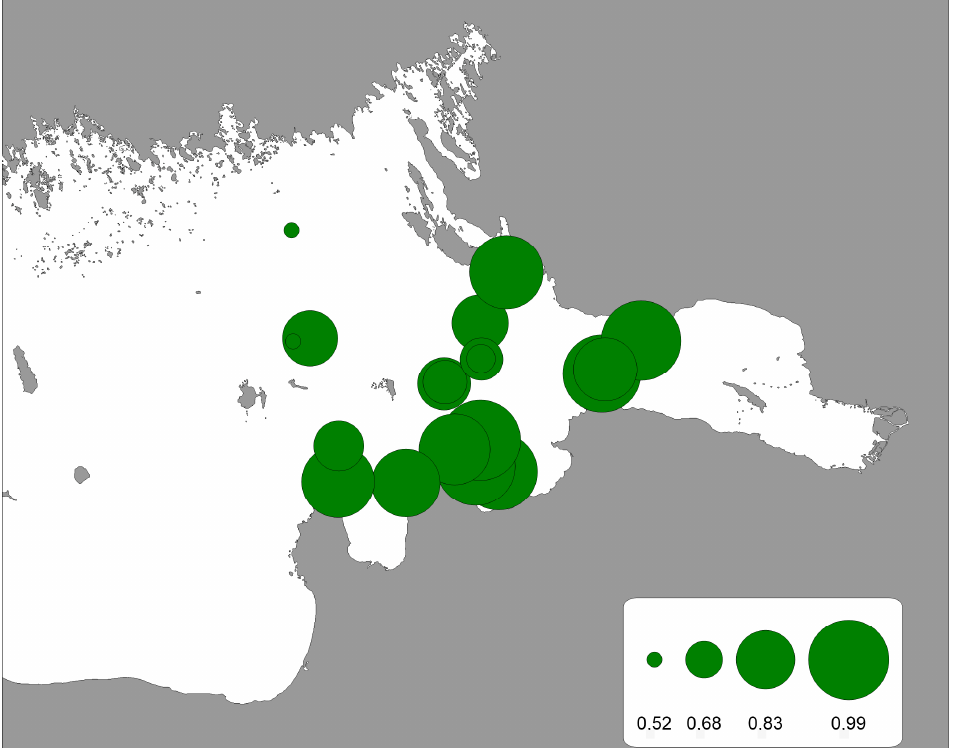
Figure 5. Benthic Opportunistic Annelids Amphipods (BO2A) index at sampling sites in the eastern Gulf of Finland.